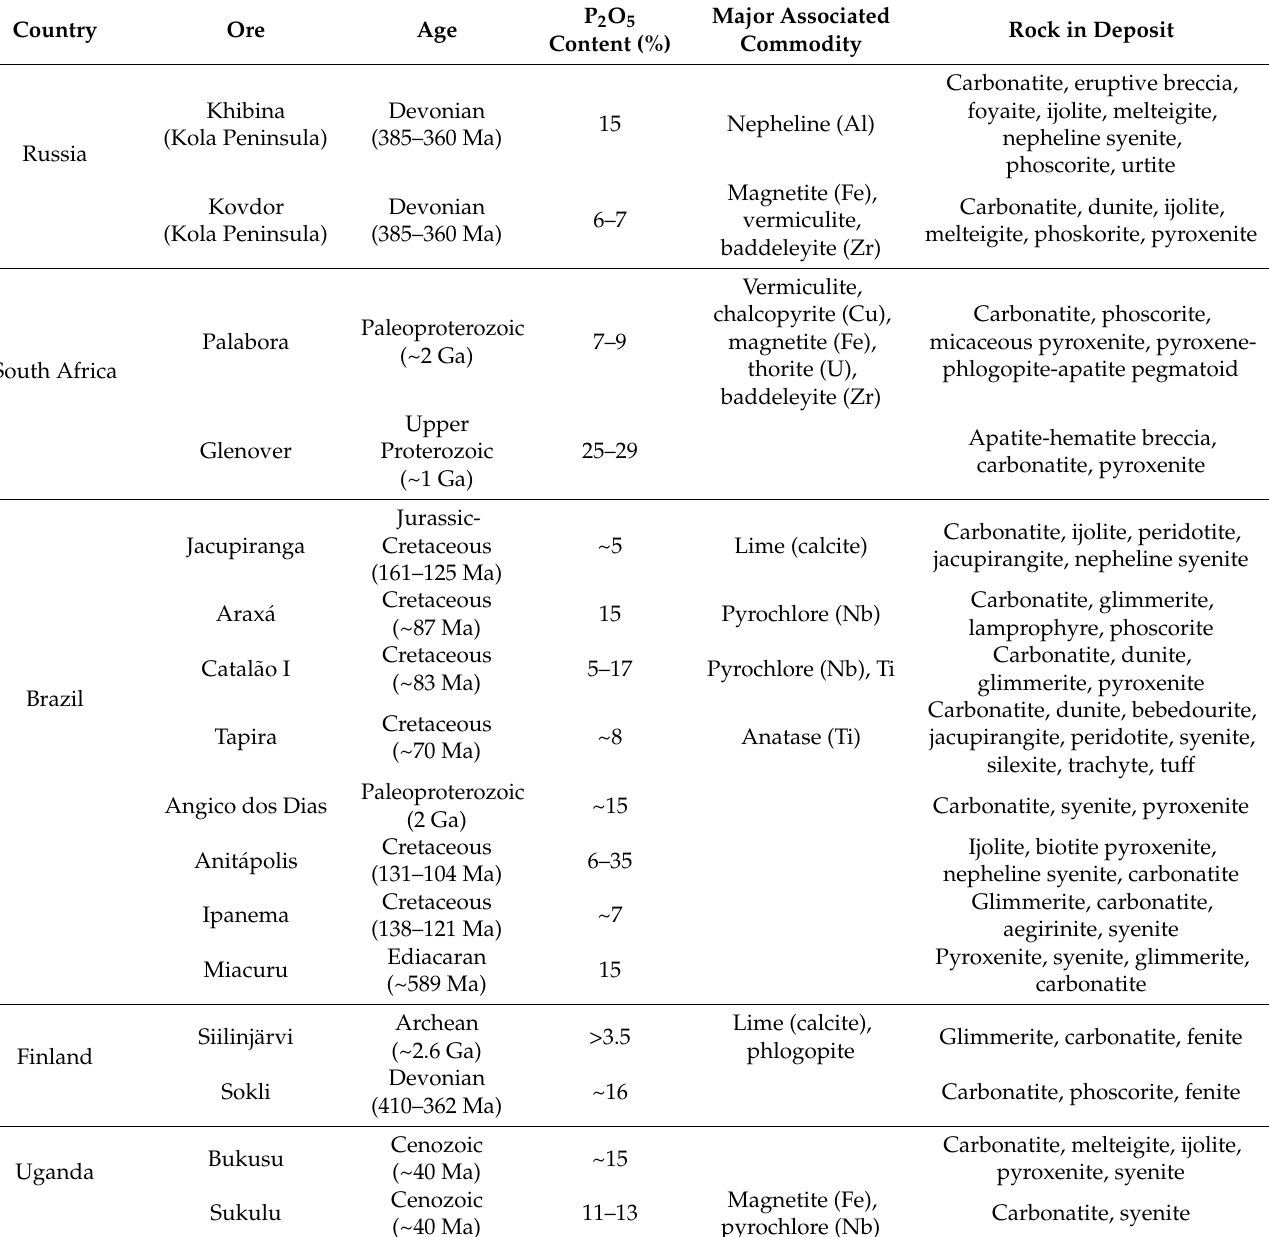
Table 1. Principal worldwide igneous phosphate ores. Data from [58,63–67] and references